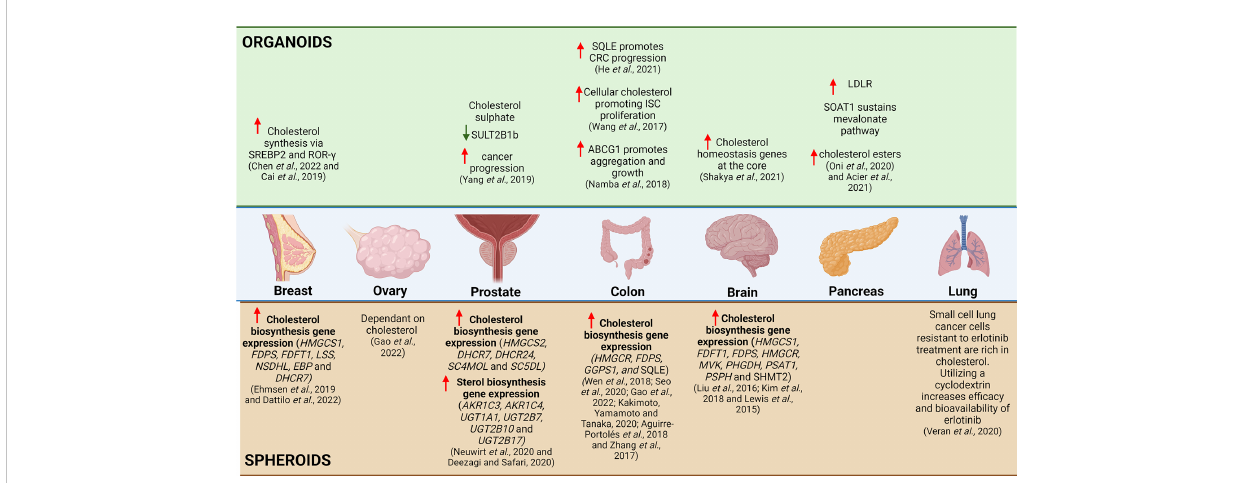
FIGURE 4 Summary of Cholesterol Related Research Utilizing 3D in-vitro Models. Based on literature, studies investigating the relationship between breast cancer and cholesterol, it was evident that increased cholesterol synthesis occurs via SREBP2 in organoids and that there is increased cholesterol biosynthesis gene expression in spheroids. The relationship between cholesterol synthesis and ovarian cancer has yet to be explored in organoids, but in a small study utilizing spheroids, it was shown that the ovarian cancer spheroids are dependent on cholesterol. In prostate cancer, the utilization of organoids has illustrated that cholesterol sulphate decreases SULT2B1b, which correlates to increased cancer progression and in spheroids it has illustrated increased expression of cholesterol biosynthesis genes and sterol biosynthesis genes. The use of intestinal organoids has shown that SQLE increases CRC progression, increased cellular cholesterol promoting ISC proliferation and increased ABCG1 promotes aggregation and growth of intestinal cancer cells, whereas spheroids have illustrated increased expression of cholesterol biosynthesis genes. In glioblastoma, the use of spheroids have illustrated increased expression of cholesterol biosynthesis genes and in organoids it was shown that there was increased expression of cholesterol homeostasis genes at the organoid core. In pancreatic cancer, organoids have been used to illustrate increased LDLR, SOAT1 sustains the mevalonate pathway and there is increased cholesterol esters present. In lung cancer, there are limited studies that explore the link between cholesterol and cancer, but a small study has illustrated that utilizing a cyclodextrin as a drug vehicle for delivery in cholesterol-rich erlotinib resistant small cell lung cancer cells can be a potentially useful therapeutic